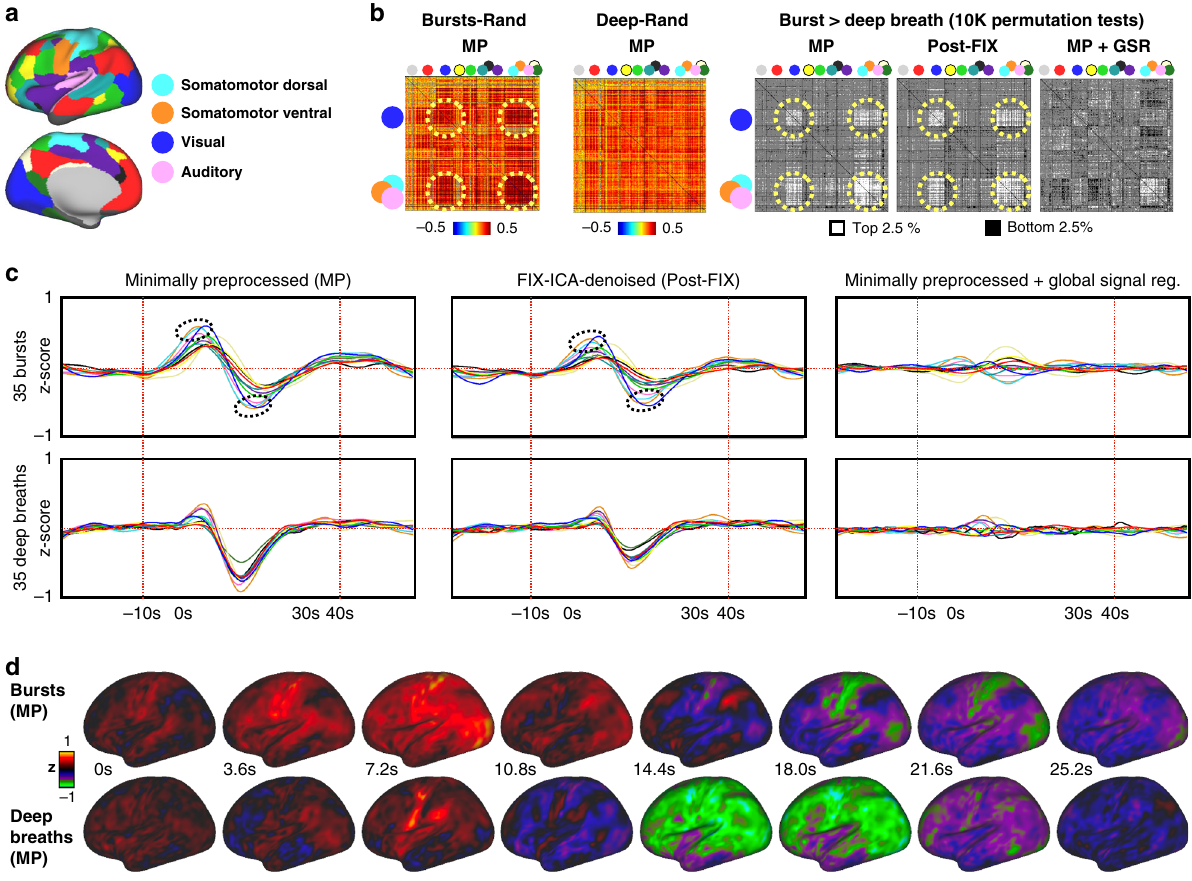
Fig. 5 Spatiotemporal properties of bursts and deep breaths. a Color legend of network locations and colors from ref. 17 , with text labeling of the networks of particular interest for this paper (full legend in Supplementary Fig. 11). b Correlation matrices are derived from spans of − 10 to 40 s about the event onsets shown in Fig. 3 in minimally preprocessed data (red dotted lines in c ), and show mean differences of 35 bursts and 35 deep breaths compared to 35 random onsets, only coloring cells signi fi cant at p < 0.05 by 10,000 permutation tests (nearly all cells are signi fi cant; non-signi fi cant cells are colored gray). In grayscale matrices at right, matrices of bursts were contrasted to deep breaths via 10,000 permutation tests, and the top and bottom 2.5% of actual differences among permutation ranks are illustrated (in white and black; gray is insigni fi cant) in matrices for minimally preprocessed (MP), FIX-ICA- denoised (Post-FIX), and minimally preprocessed time series plus global signal regression (GSR). Differences exist under each processing strategy, prominently including visual, auditory, and somatomotor cortex (blue, pink, orange, and cyan). c Mean signals of 35 patterns from each kind of time series in b , with mild smoothing, colored by the legend above. Dotted ovals encircle the peaks and troughs of the aforementioned sensorimotor networks. d Surface representations of the events, the same data in b and c , in minimally preprocessed time series. Supplementary Movie 5 animates these patterns and those of non-respiratory motion onsets and random